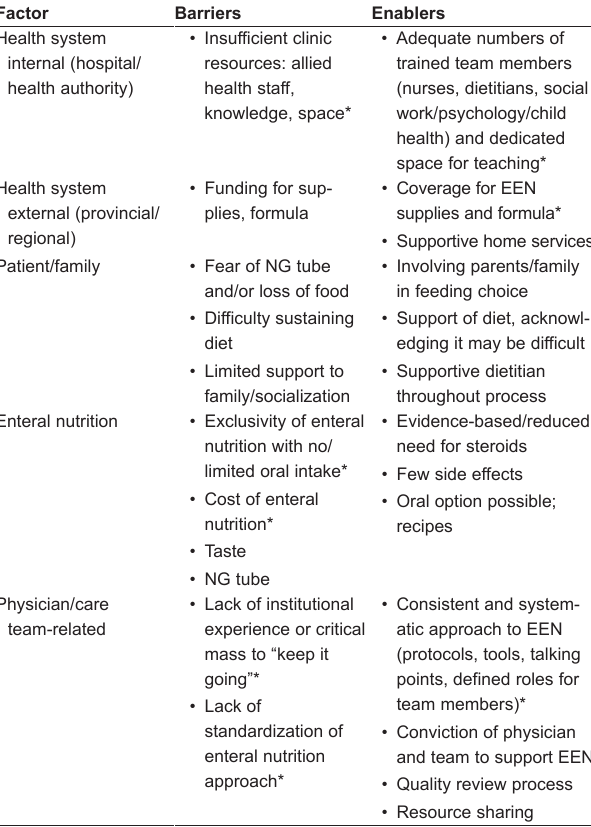
TAble 1 Thematic summary of patient and family interviews Factors/themes (with